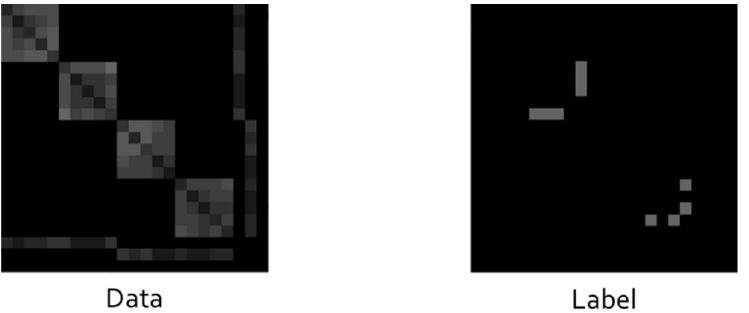
Figure 4. The visualization of data instance.